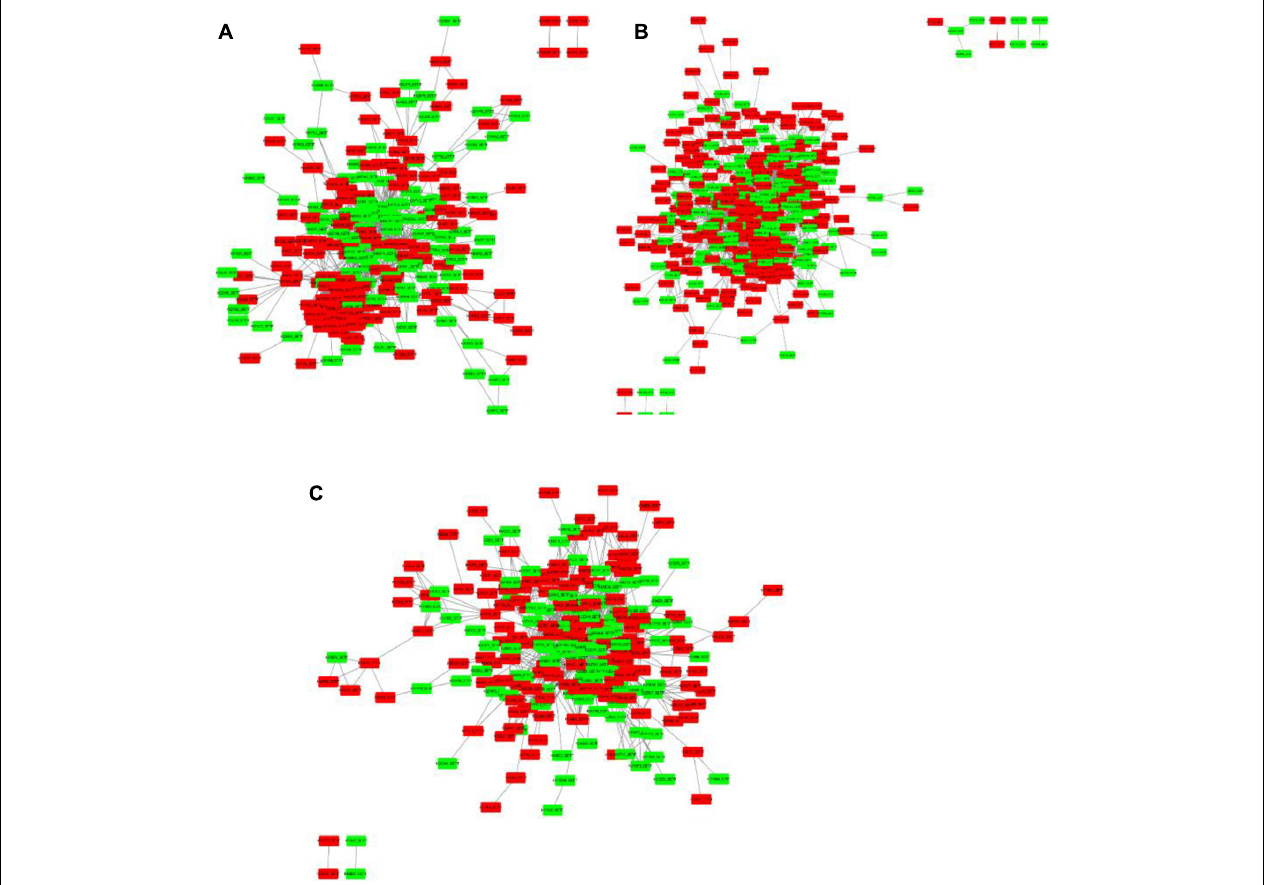
FIGURE 9 | Protein-protein interaction (PPI) analysis of the DEPs in P. antidotale exposed to salt treatments: (A) low salinity/control, (B) high salinity/control, and (C) high salinity/low salinity. The boxes represent proteins while the straight lines represent the interactions between different proteins. Red boxes indicate the upregulated DEPs and green arrows indicate the downregulated